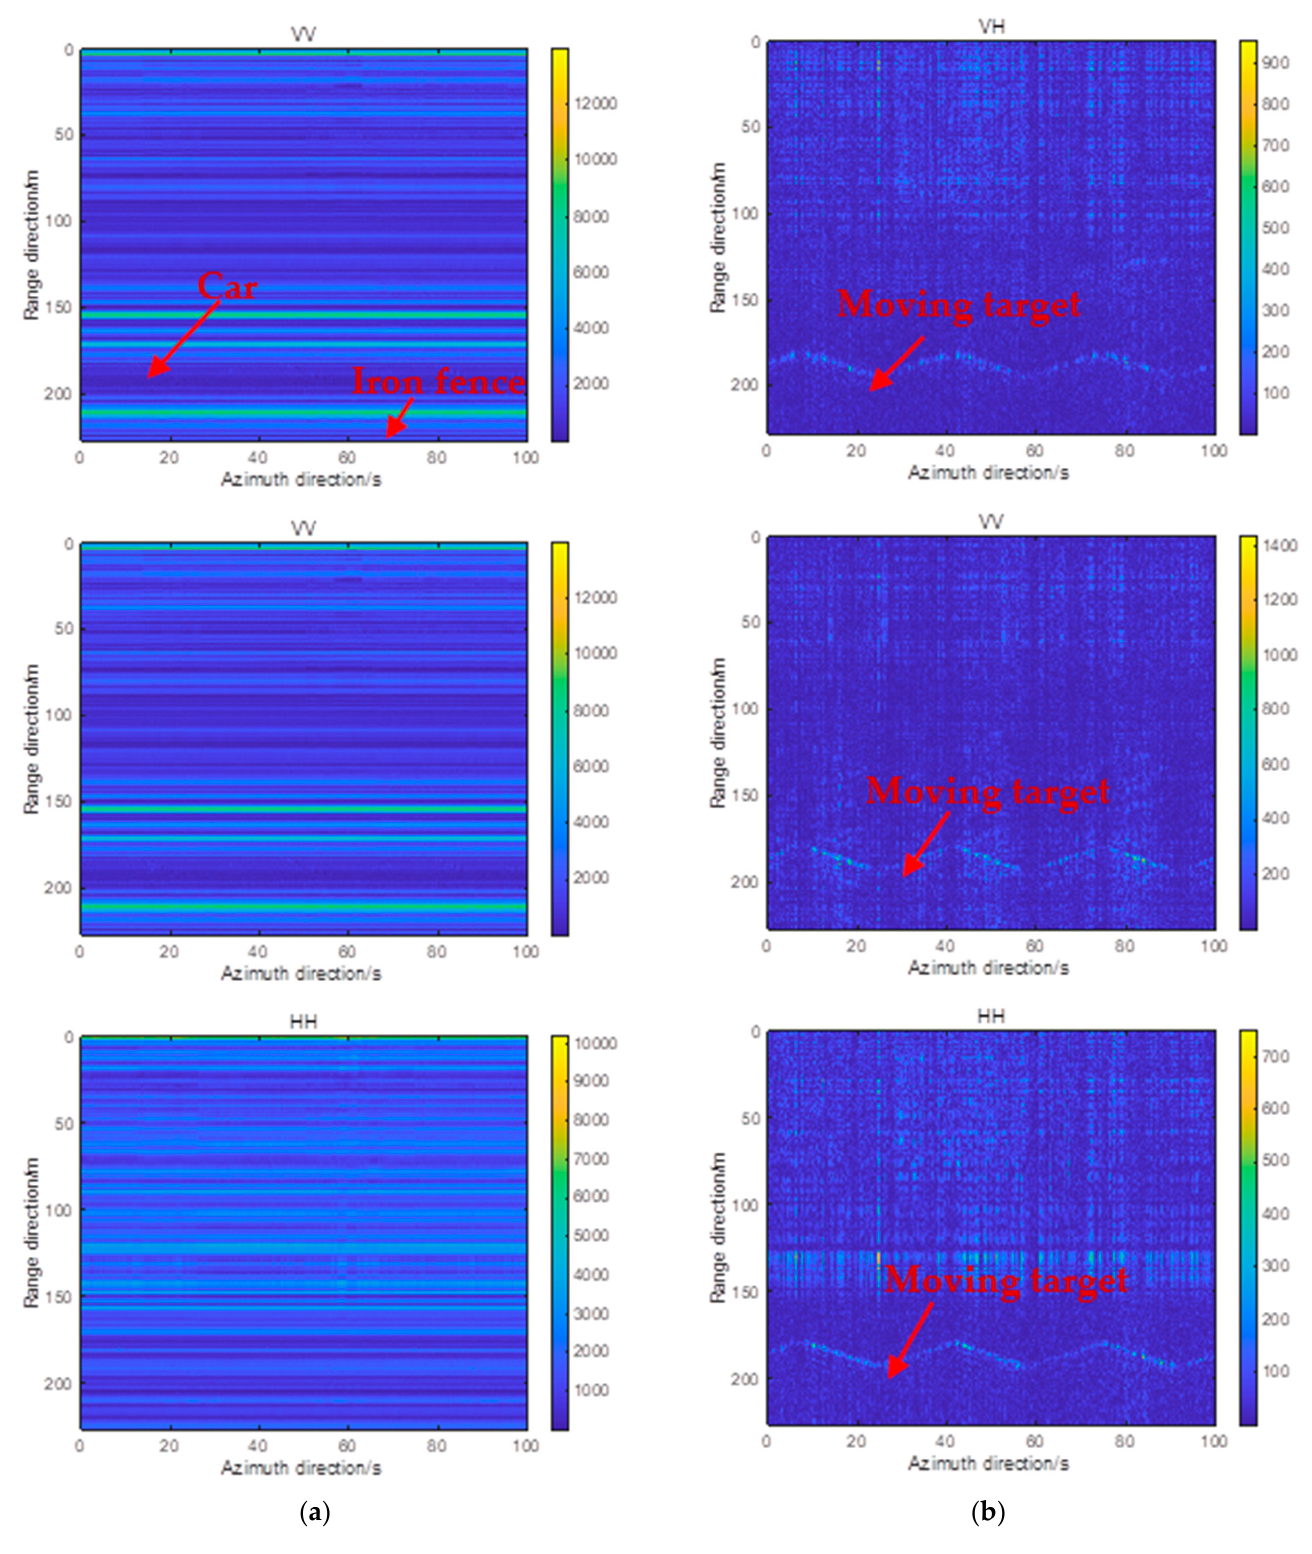
Figure 9. Two-dimensional range profiles of echo signal. ( a ) Before background removal. ( b ) After background removal.